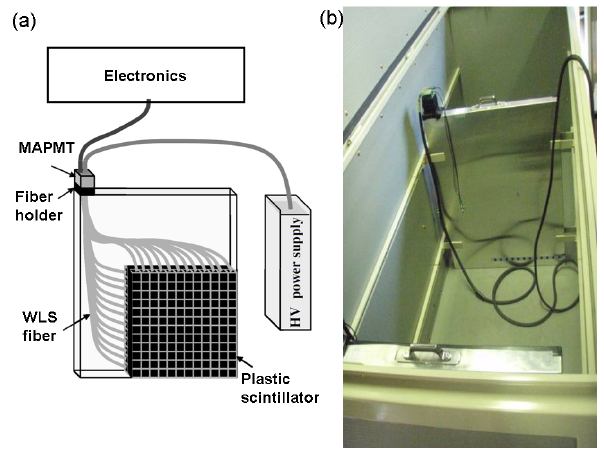
Fig. 1. Schematic view of the position sensitive detector (PSD) plane (a) and a photograph of the present experimental setup in a steel housing (b). The housing was designed so that the distance between two PSD planes is adjustable, and the inside air pressure is controllable.